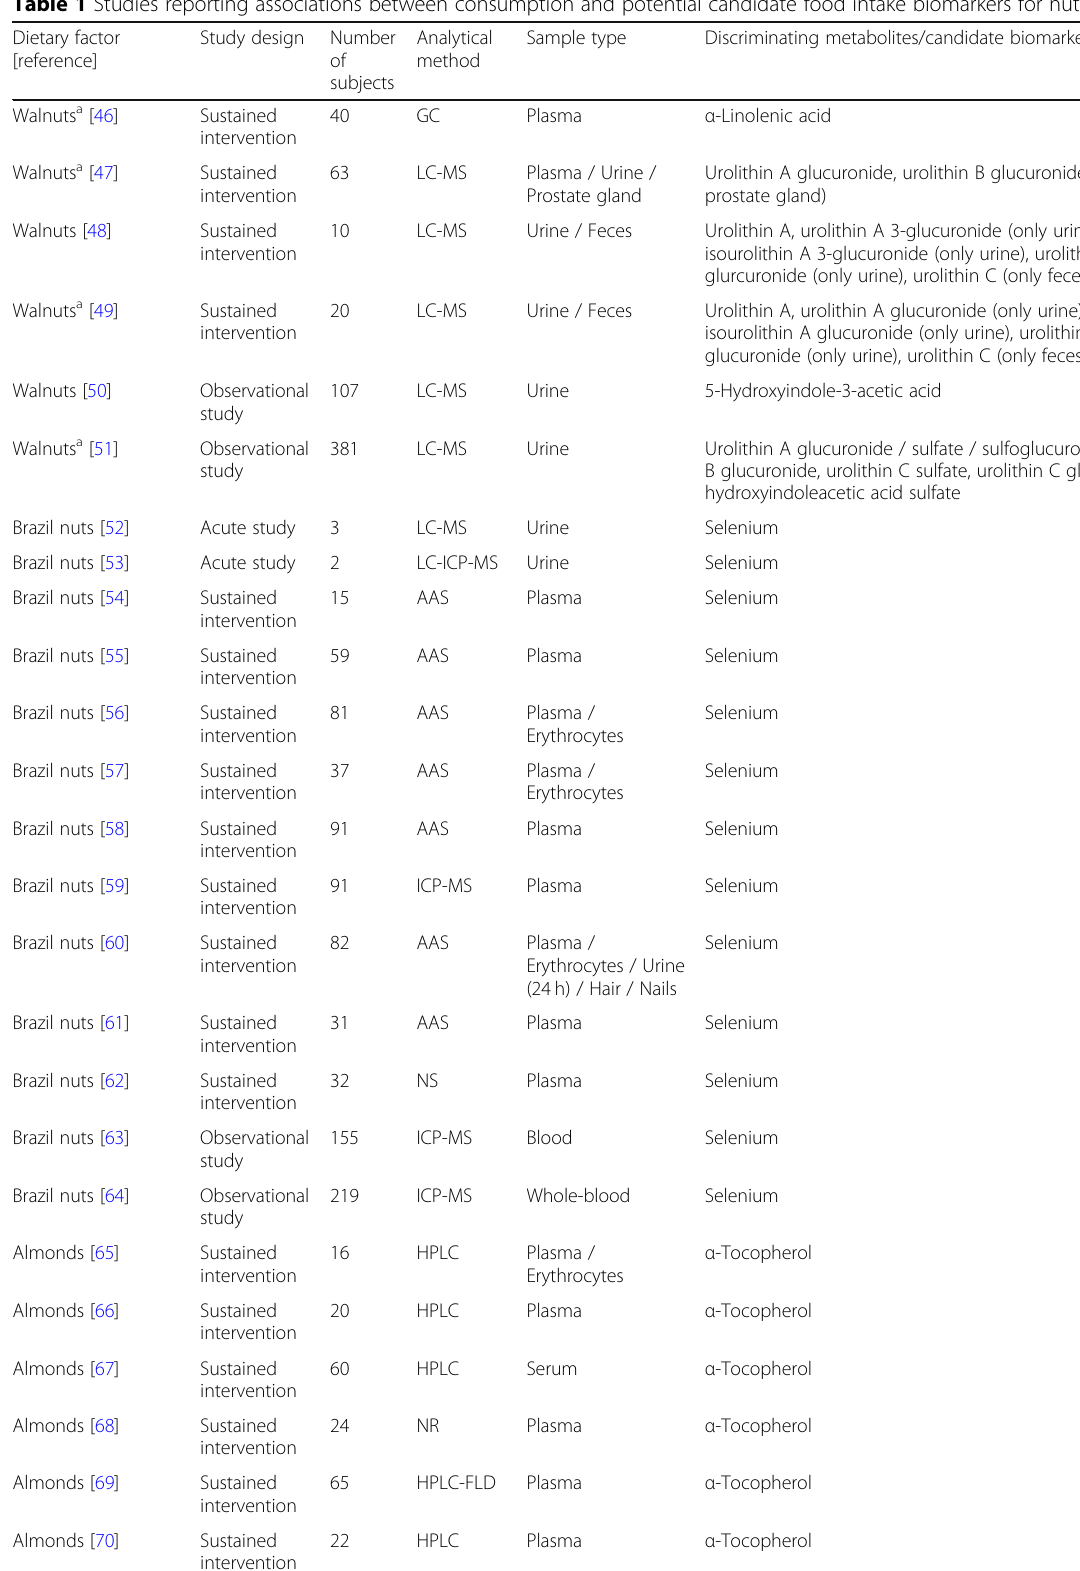
Table 1 Studies reporting associations between consumption and potential candidate food intake biomarkers for nuts